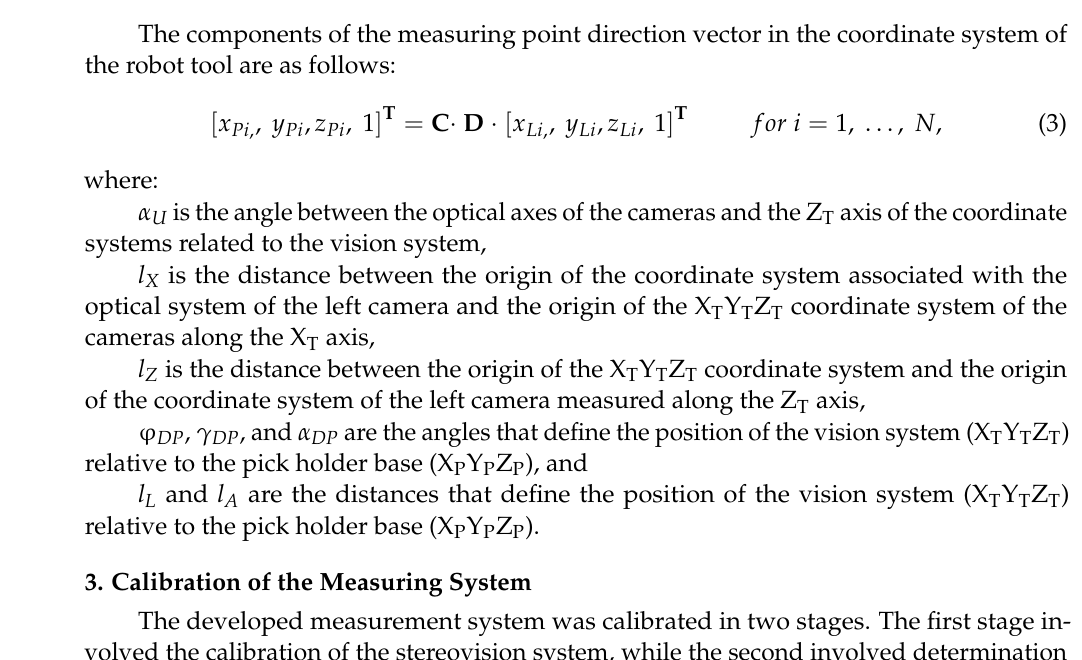
Figure 5. A grid of points in the coordinate system associated with: ( a ) the vision system’s left camera, ( b ) the robot tool’s pick holder base, and ( c ) the relationship between the coordinate system associated with the vision system and the coordinate system associated with the vision system’s left camera.